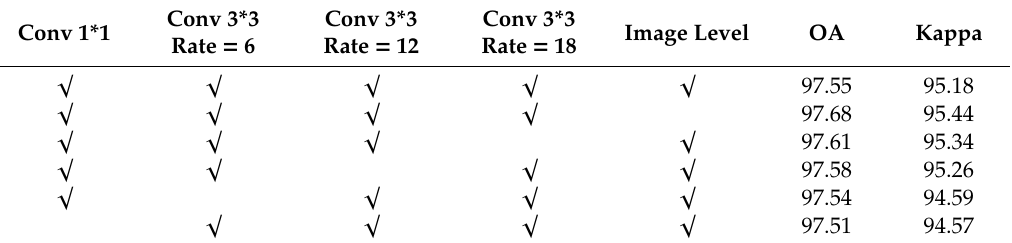
Table 1. Comparison of the classification performance of the di ff erent ASPP branches.